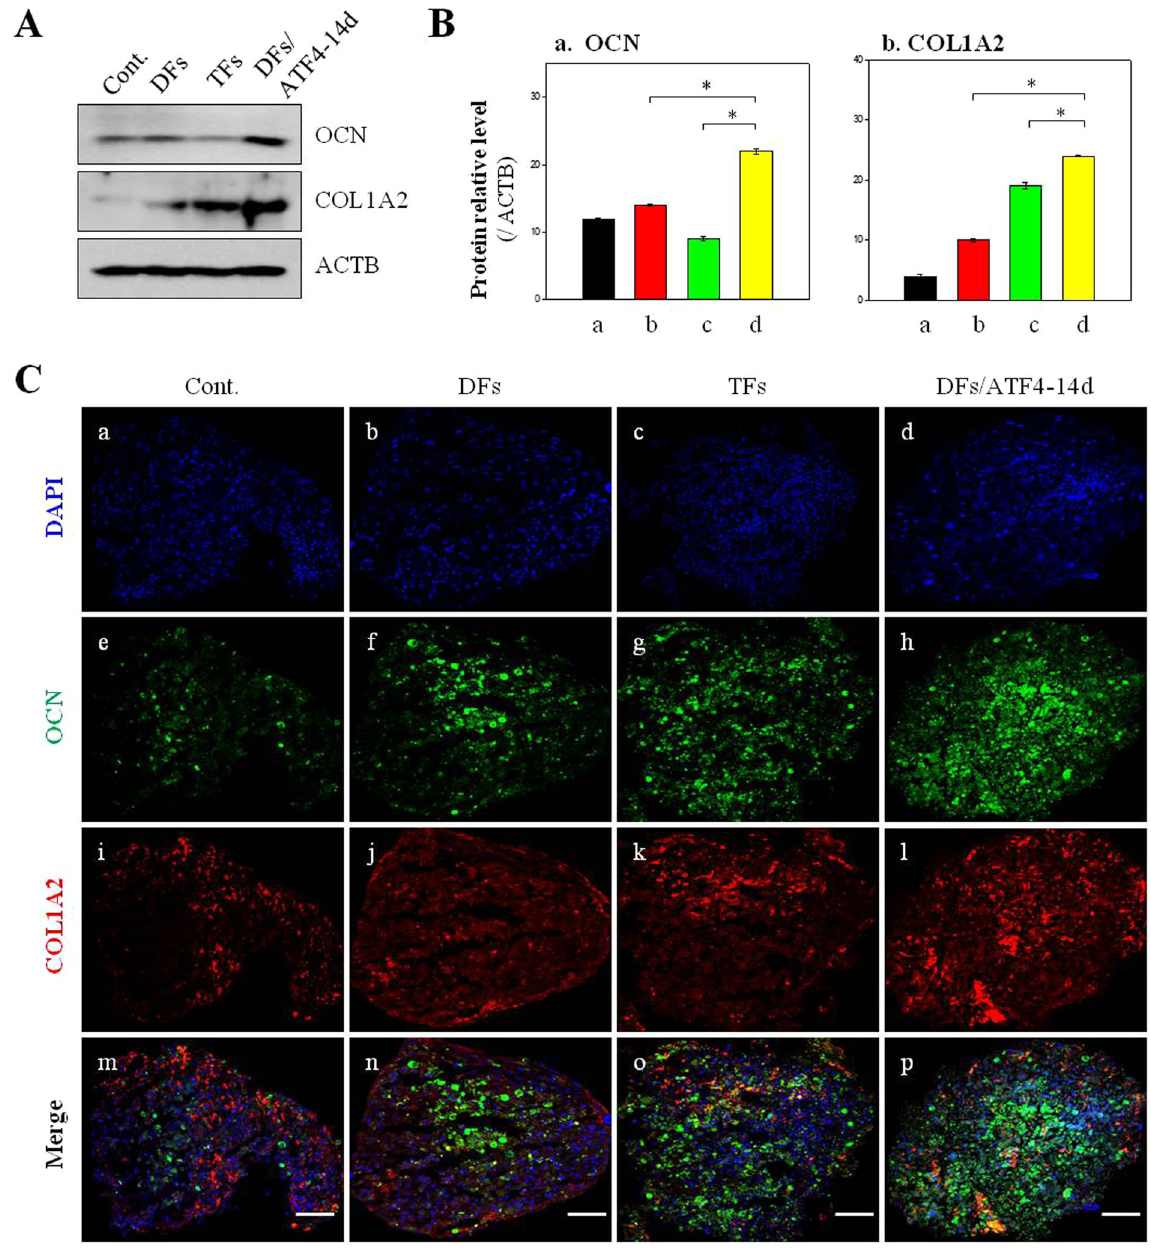
Figure 8. Osteogenesis of hMSCs transfected with two and three genes determined by Western blot analysis, quantification of protein levels, and immunohistology. ( A ) Western blot analysis of hMSCs transfected with two and three genes. ( B ) Quantification of (a) OCN and (b) COL1A2 protein levels in hMSCs transfected with two and three genes. * P < 0.05. ( C ) Immunohistological analysis of osteogenesis. (a–d) DAPI staining; (e–h) OCN staining; (i–l) COL1A2 staining; and (m–p) merged images. Scale bar, 200 μ